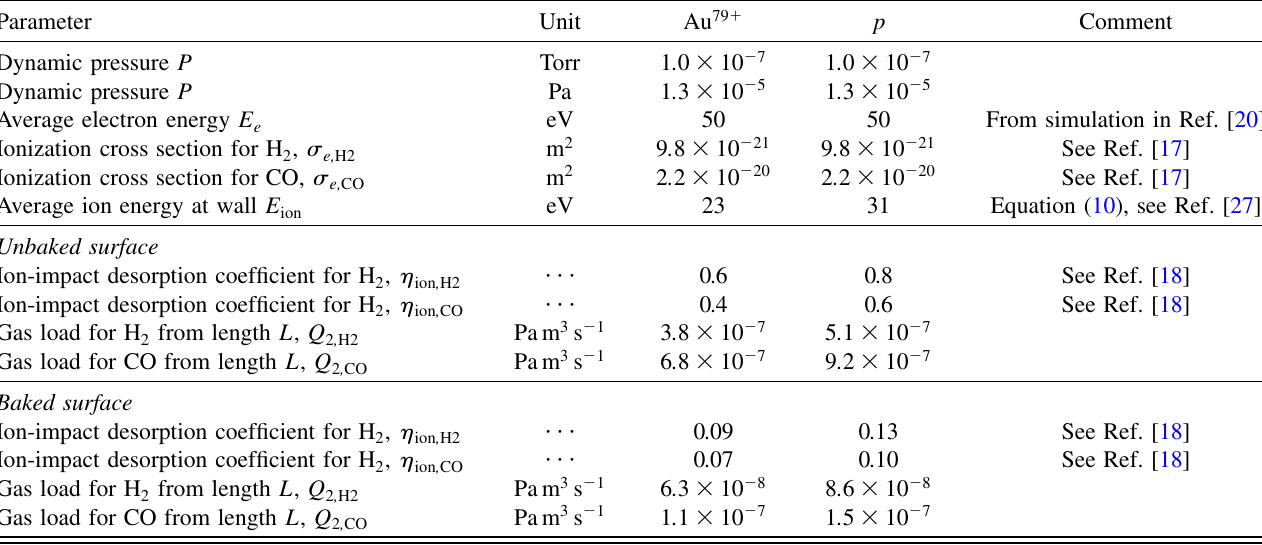
TABLE IV. Estimate of gas load Q in the warm vacuum regions due to residual gas ionization by cloud electrons, subsequent 2 acceleration of the ions by the beam, and ion-impact desorption.